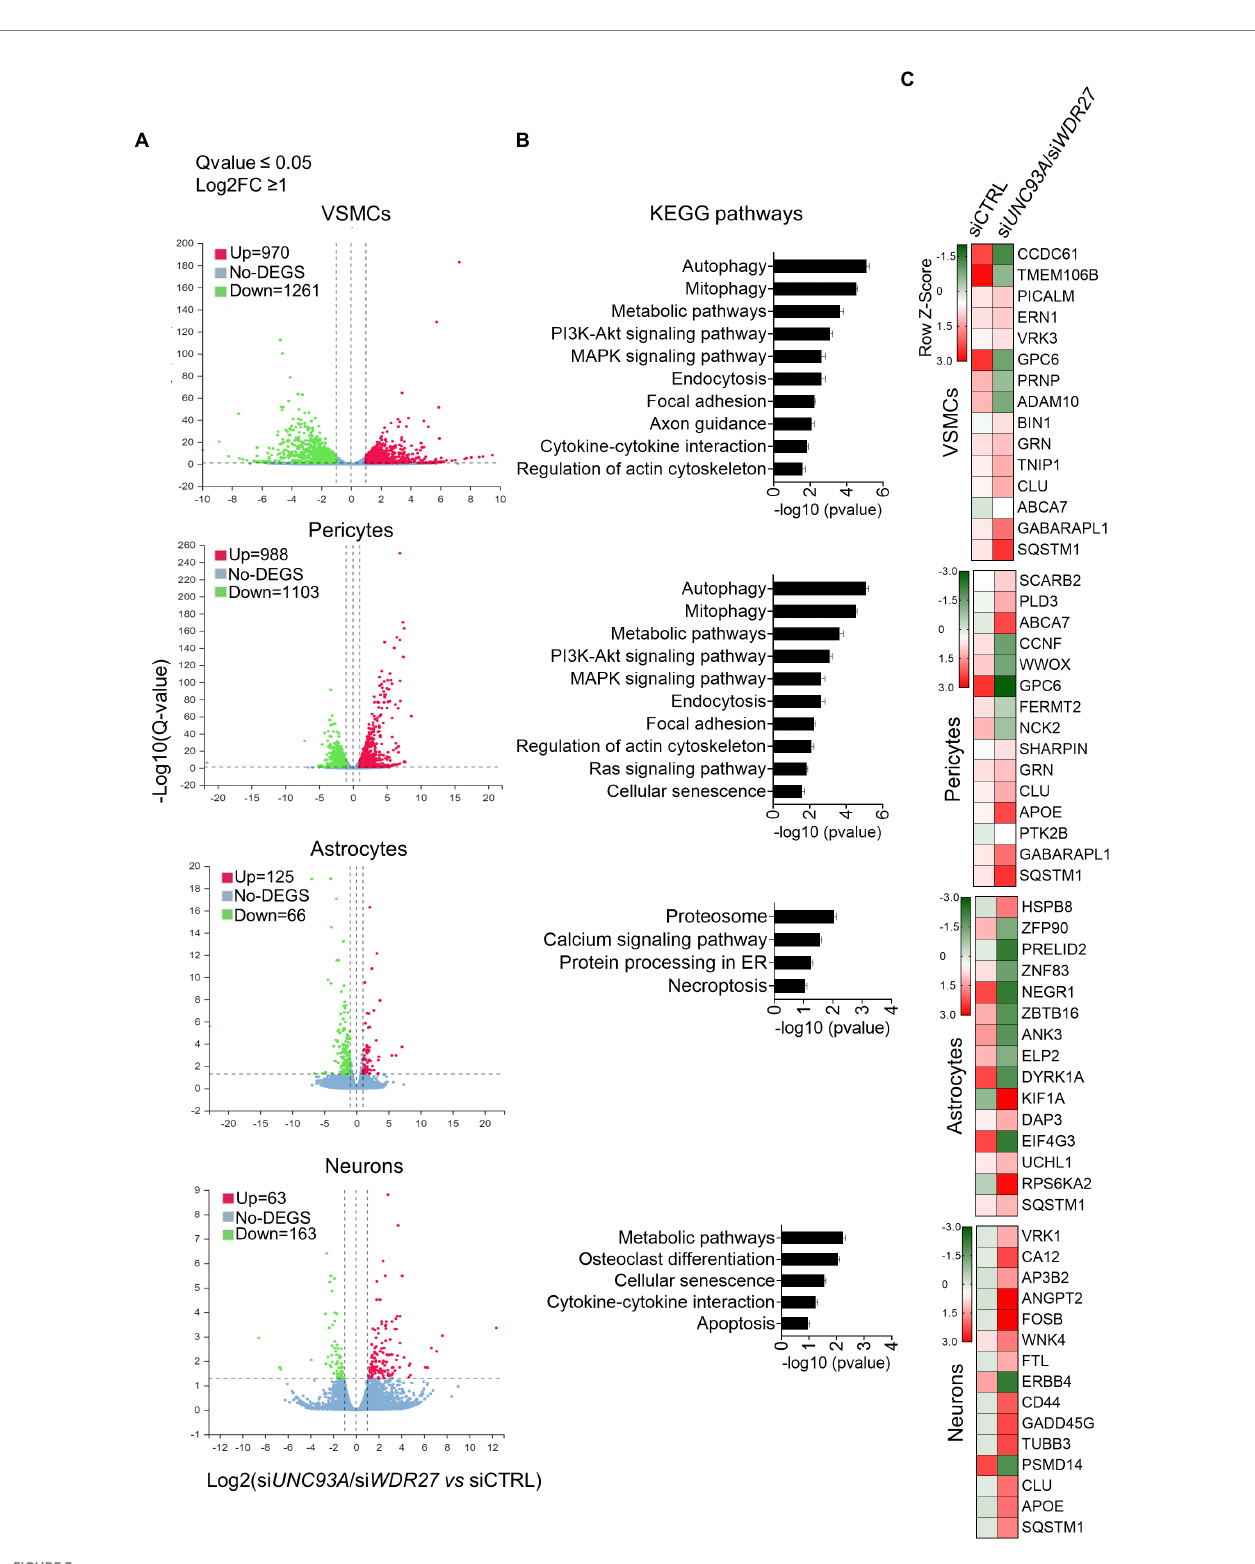
FIGURE 3 Loss of UNC93A and WDR27 affects the global transcriptomic signature of brain cell lines in vitro . (A) Volcano plot of dysregulated genes in four different brain cell types. (B) Shows the KEGG pathways analysis. (C) Heatmap of dysregulated genes previously associated with neurodegenerative